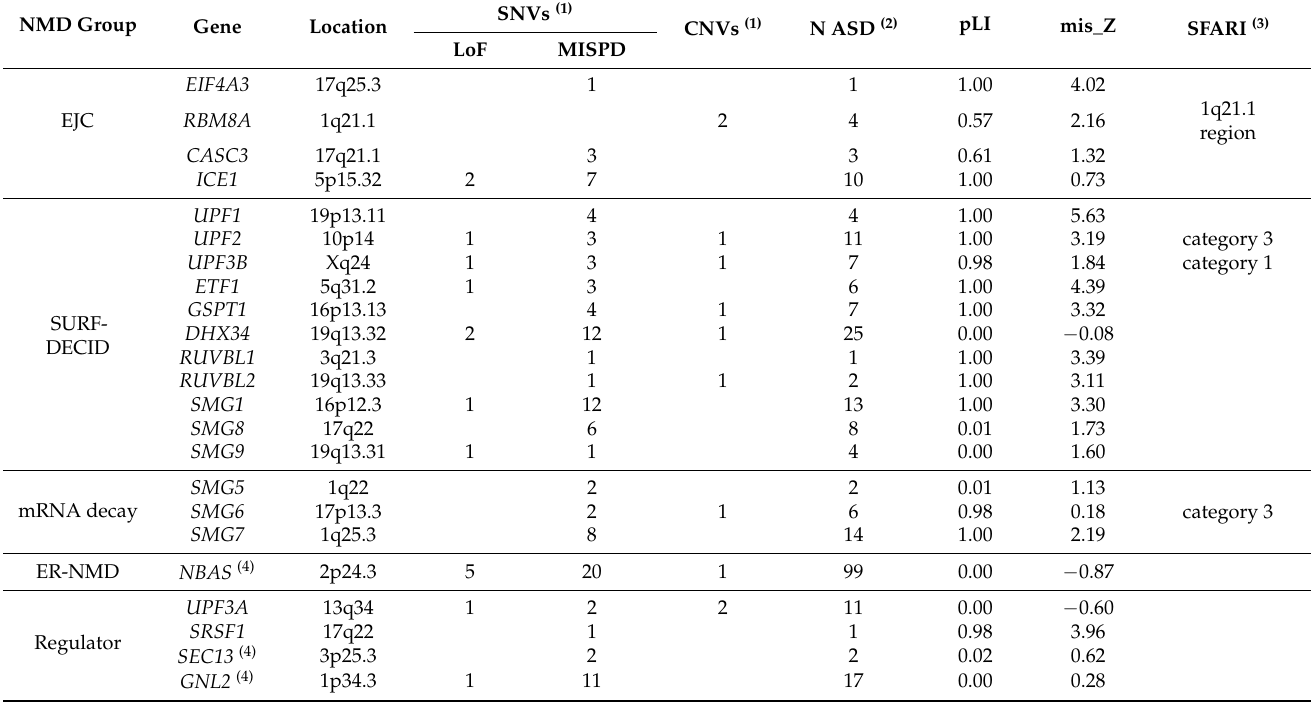
Table 3. Numbers of SNVs or CNVs identified within protein domains important for NMD in 258 ASD patients. A total of 136 genetic variants in 23 NMD genes were